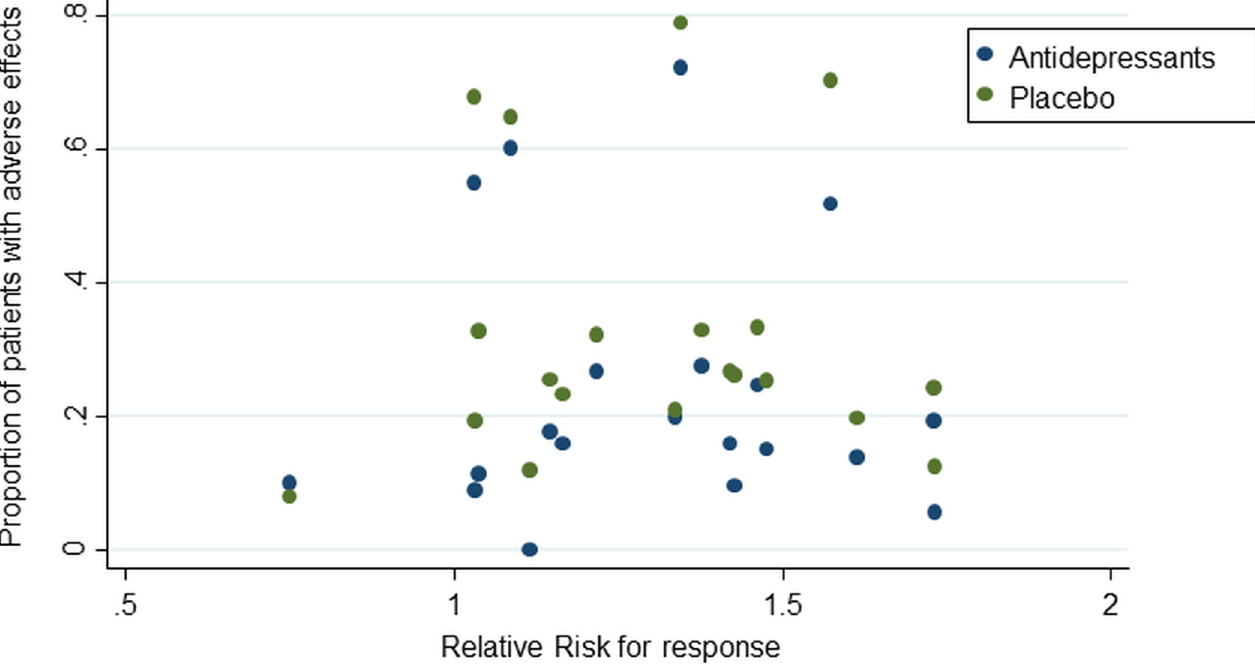
Fig 3. Adverseevents and response. Risk > 1 favours antidepressants over placebo.